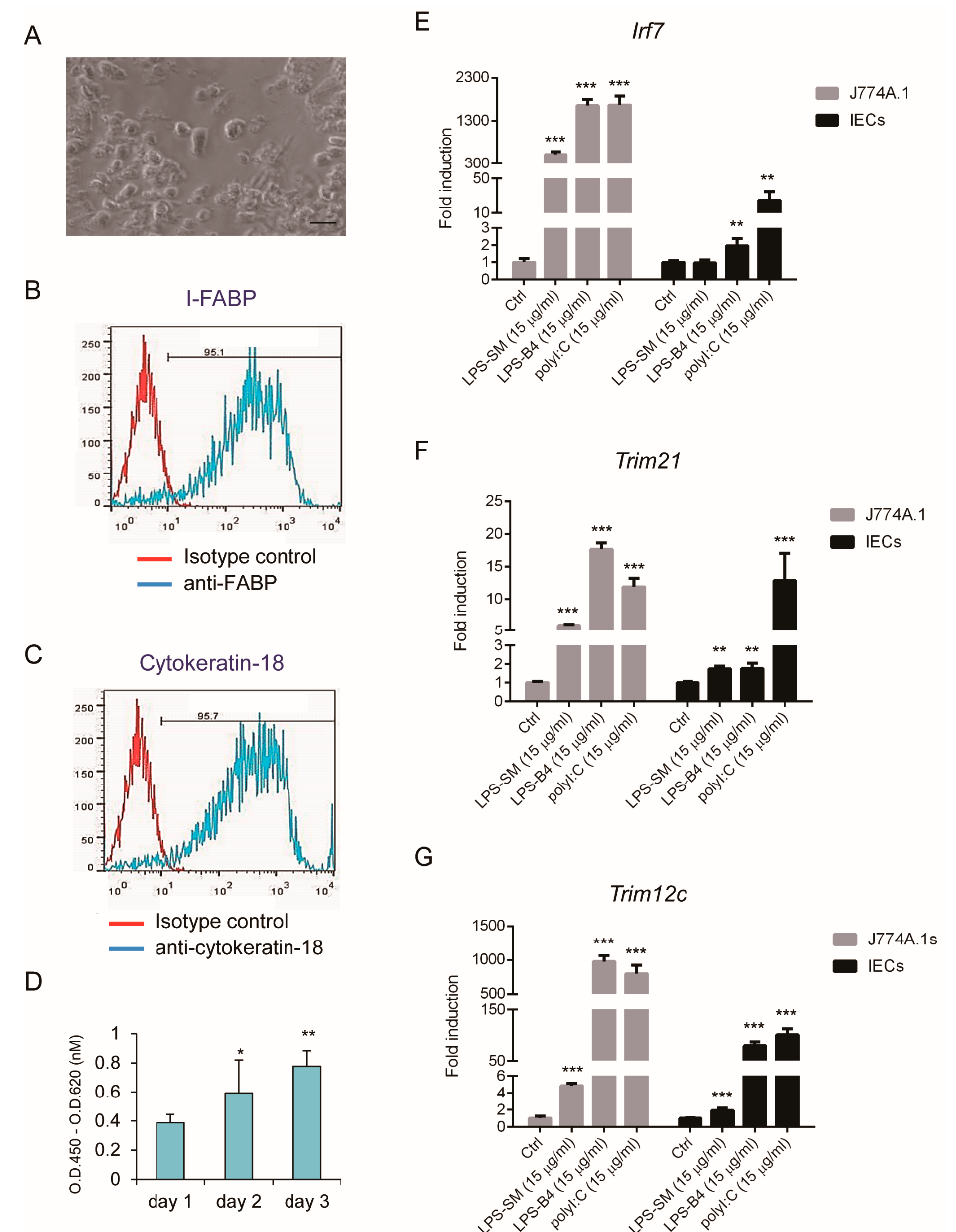
Figure 1. Isolation and cultivation of primary mouse intestinal epithelial cells (IECs). ( A ) Phase control image of IECs captured by microscopy, scale bar: 20 µ m. ( B , C ) Expression of epithelial markers I-FABP and cytokeratin-18 on IECs cells analyzed using FACS analysis with anti-IFABP and cytokeratin-18 antibodies. ( D ) IECs (5 × 10 3 ) grown in 96-well plate and their proliferation in day 1 to 3 cultures analyzed using WST-1 assay. ( E – G ) qRT-PCR analysis of mRNA expression of mouse Irf7, Trim21 , and Trim12c in 1 × 10 6 J774A.1 macrophages and IECs, stimulated with LPS of Escherichia coli . O111:B4 (LPS-B4, 15 µ g / mL), Salmonella enterica serovar Minnesota (LPS-SM, 15 µ g / mL) or poly(I:C) (15 µ g / mL) for 24 h. Relative mRNA expression normalized to that of Gapdh , and the fold induction to untreated control. Data showed as means ± SD ( n = 3). Student’s t -test *, p < 0.05; **, p < 0.01; ***, p < 0.001; compared with day 1 ( D ) or control ( E – G ), respectively.